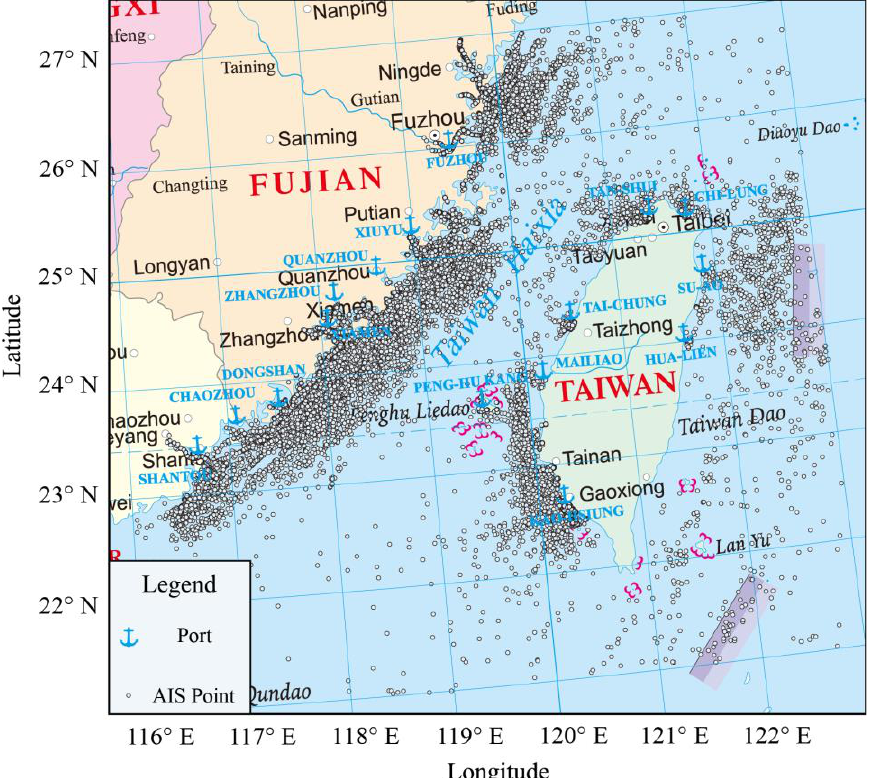
Figure 1. Study area and AIS data. Only 5% of overall AIS data is shown due to mapping effect. The background image is the standard map of the Ministry of Natural Resources of China, and the review number is GS(2020)4634. Table 1. Key attributes of AIS data used in this study.